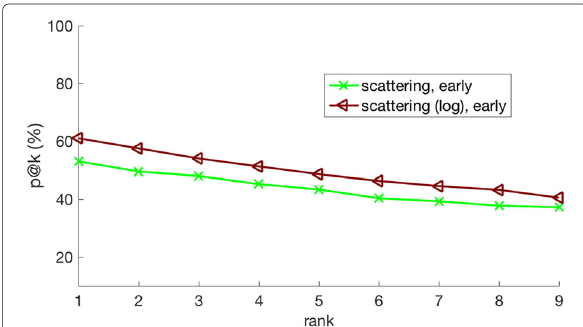
Fig. 5 Acoustic scene similarity retrieval in the DCASE 2013 private dataset: precisions at rank k ( p @ k ) obtained for scattering with or without logarithmic compression, as a function of the rank k